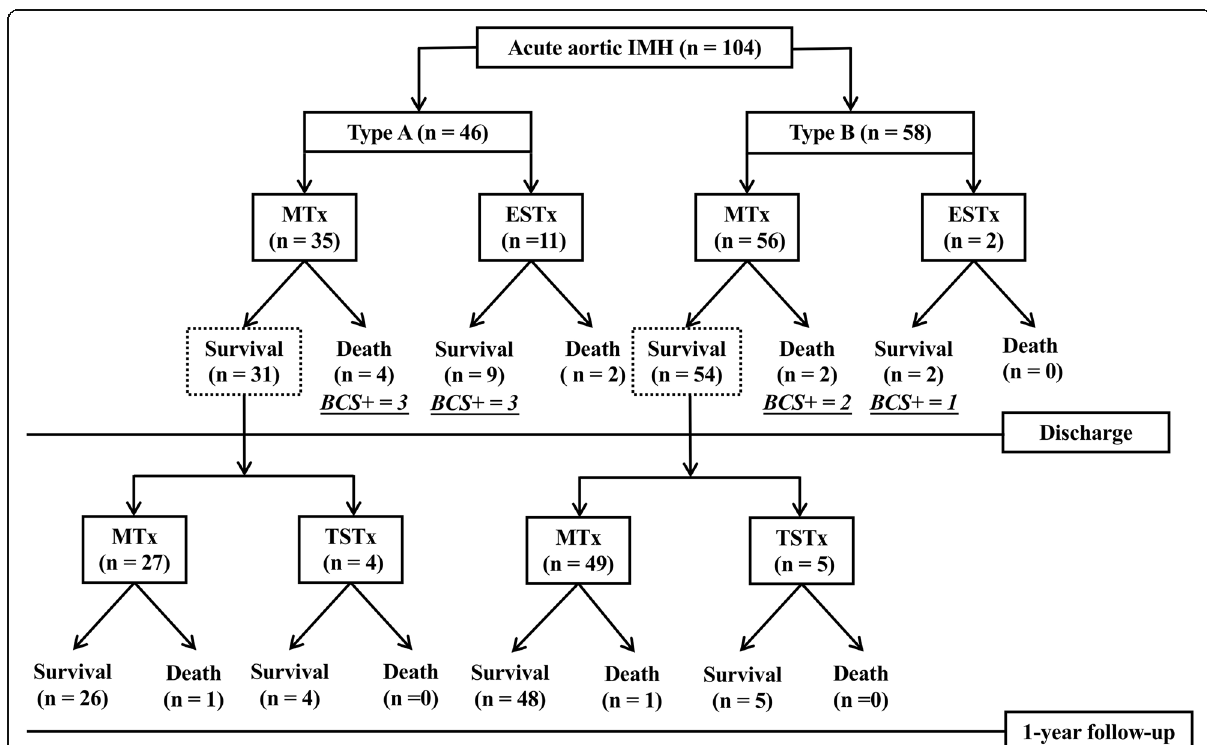
Fig. 1 Selected treatment and outcomes of 118 patients with acute aortic IMH. MTx = medical treatment, ESTx = early surgical or endovascular treatment, BCS+ = positive broken-crescent sign on CT, TSTx = timely surgical or endovascular